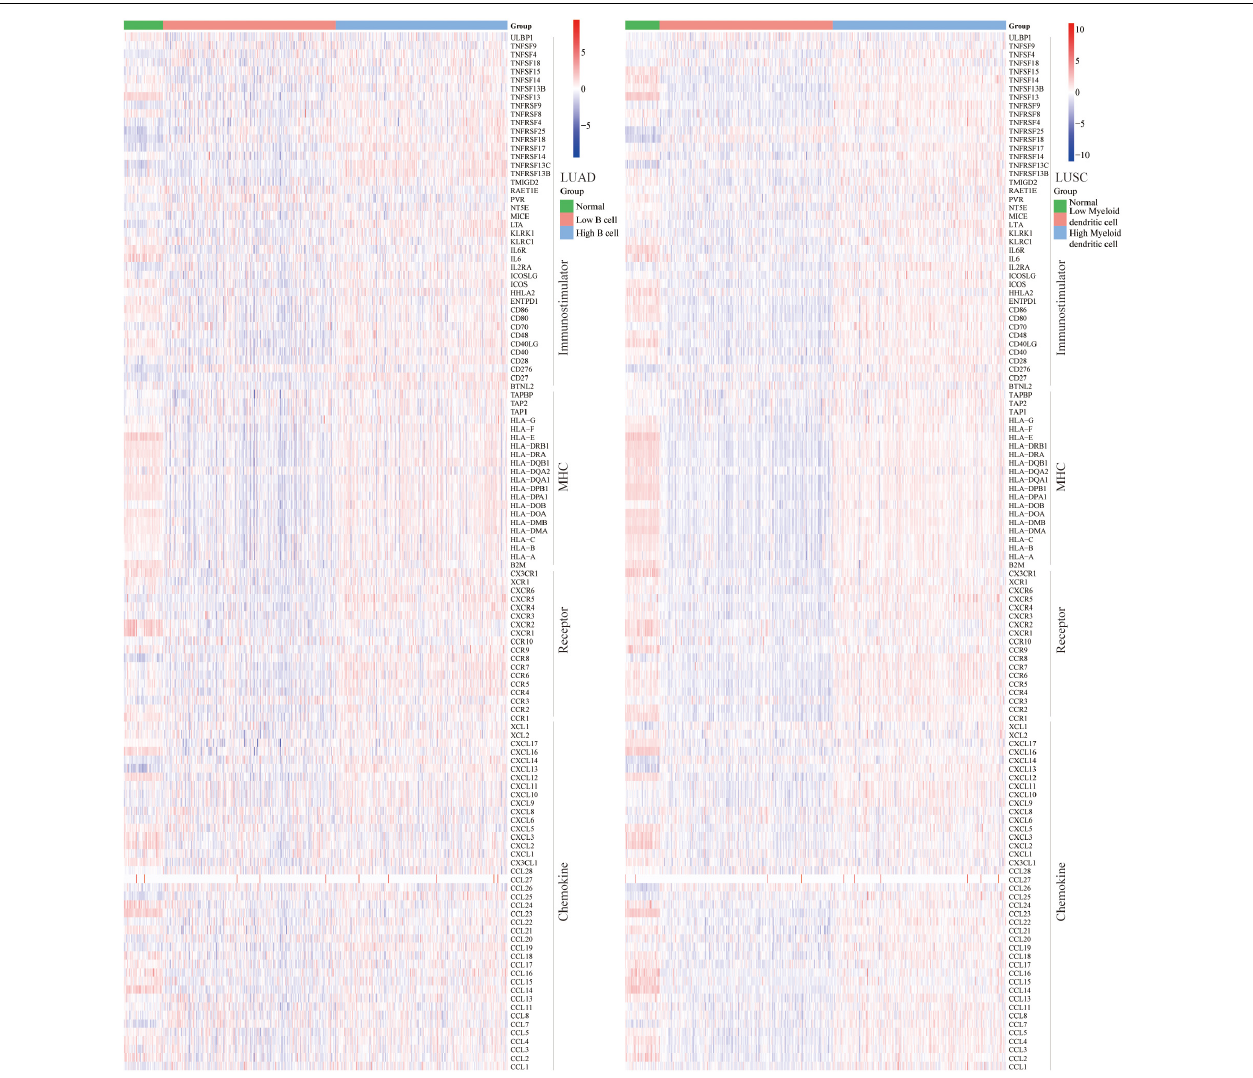
FIGURE 5 | Heatmaps of immunomodulators (immunostimulators, MHC, receptors, and chemokines). Most immunomodulators were upregulated in the high-infiltration group. Each column represents a sample, and each row represents one of the immunomodulators. The expression level of immunomodulators was displayed in different colors, transitioning from blue to red with increasing